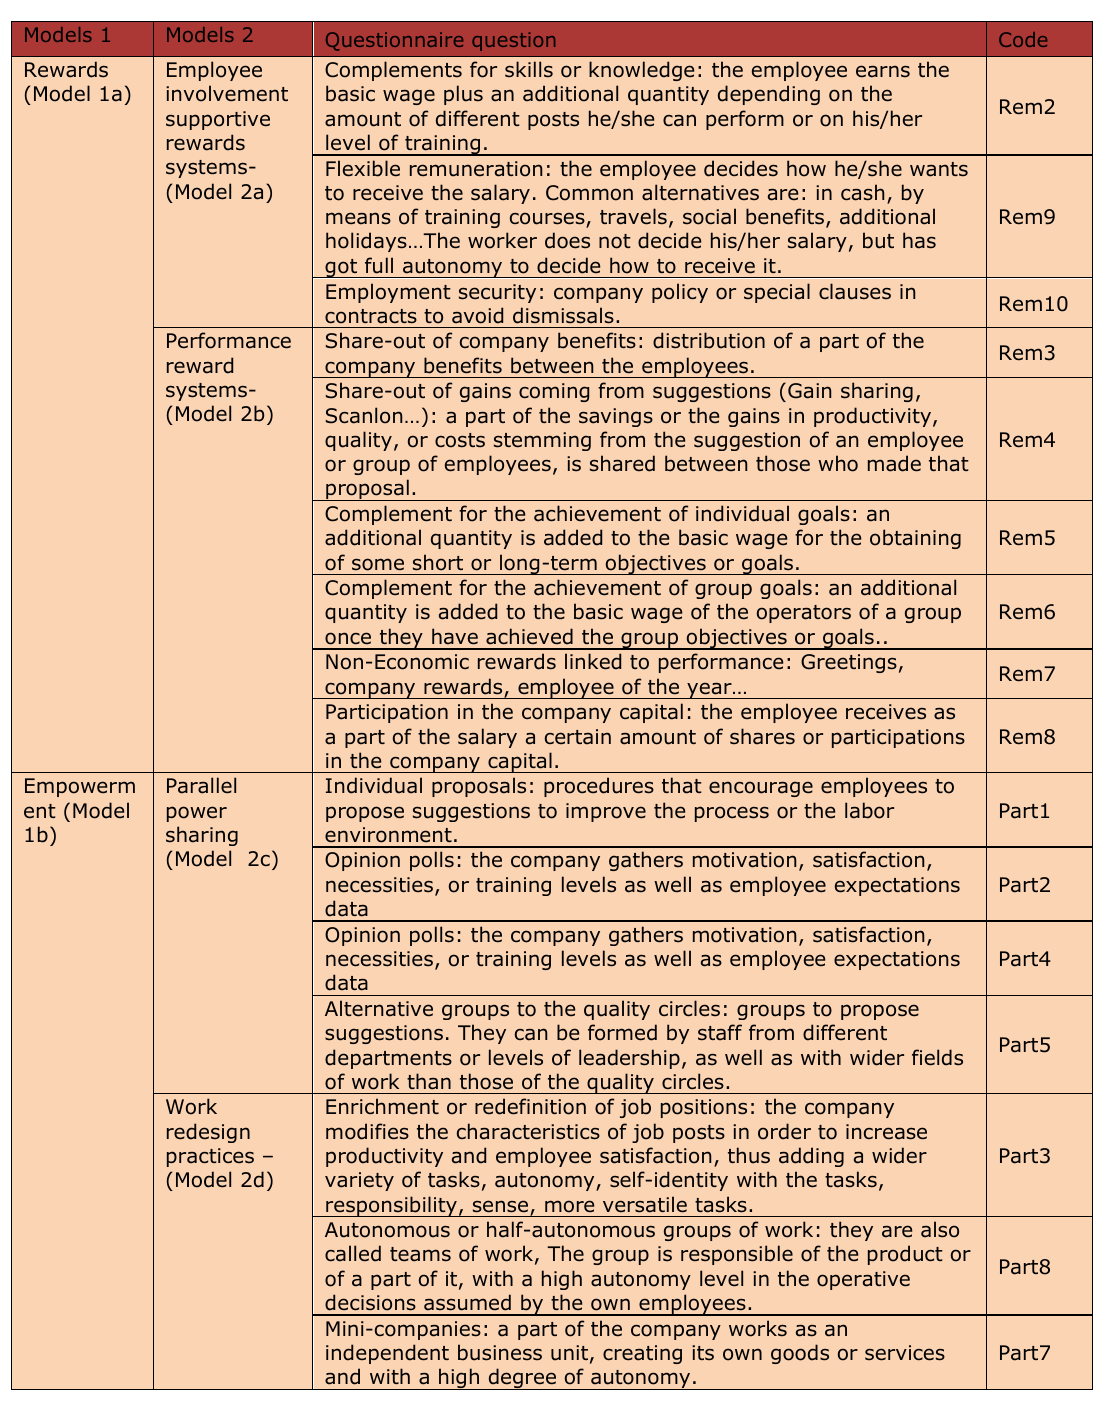
Table 2. Rewards and Empowerment Constructs and dimensions in Type A questionnaires (Lawler III et al.,